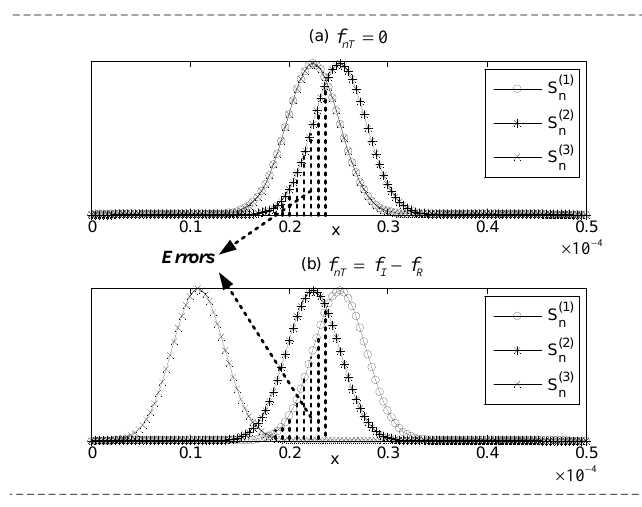
Figure 6. The PDF curves for S (1) n , S (2) n and S (3) n with (a) f nT = f I and (b) f nT = f I − f R , respectively, and γ = 0 dB.